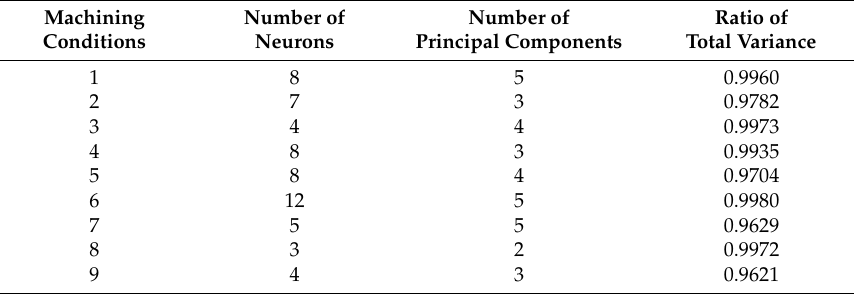
Table 5. Machining conditions and BPNN model